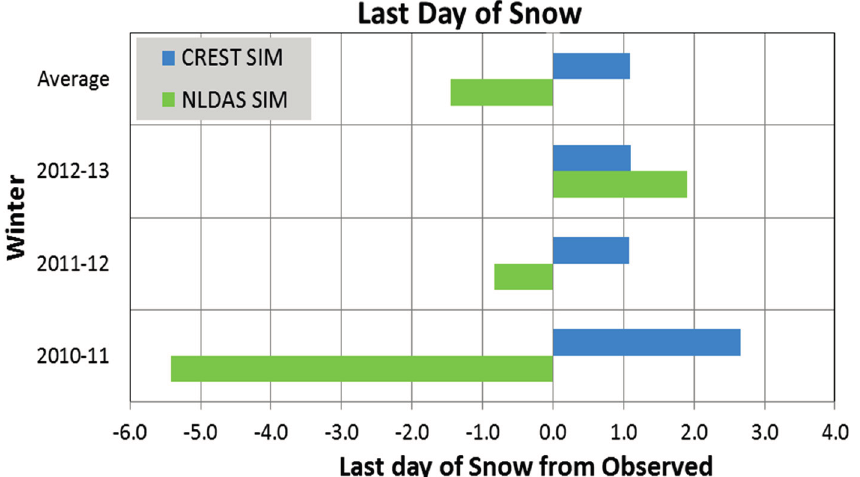
Figure 9. Last day of snow. This plot assumes the last day of snow as the 1st day of observed snow depth under 3 cm. Zero is the observed last day of snow and the bars represent the time difference between the simulated and observed last day of